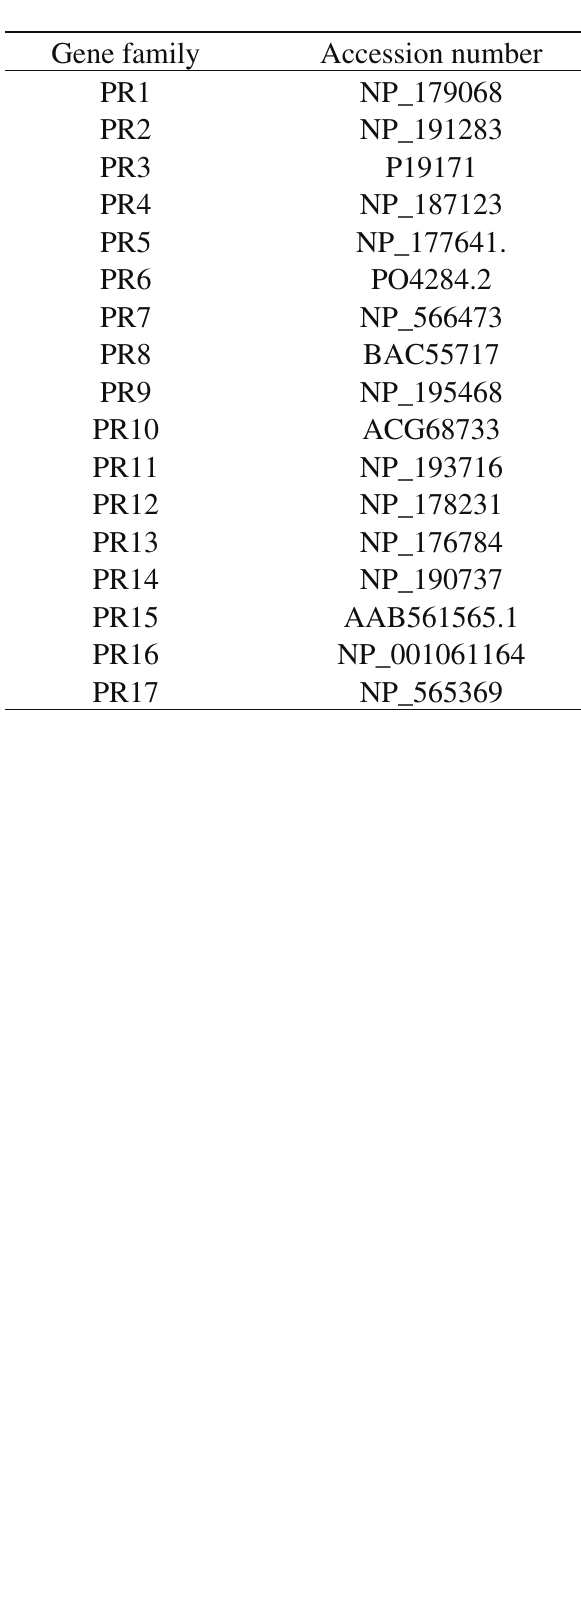
Table S1 - Accession number of reference PR -genes used as seed sequences available at GenBank